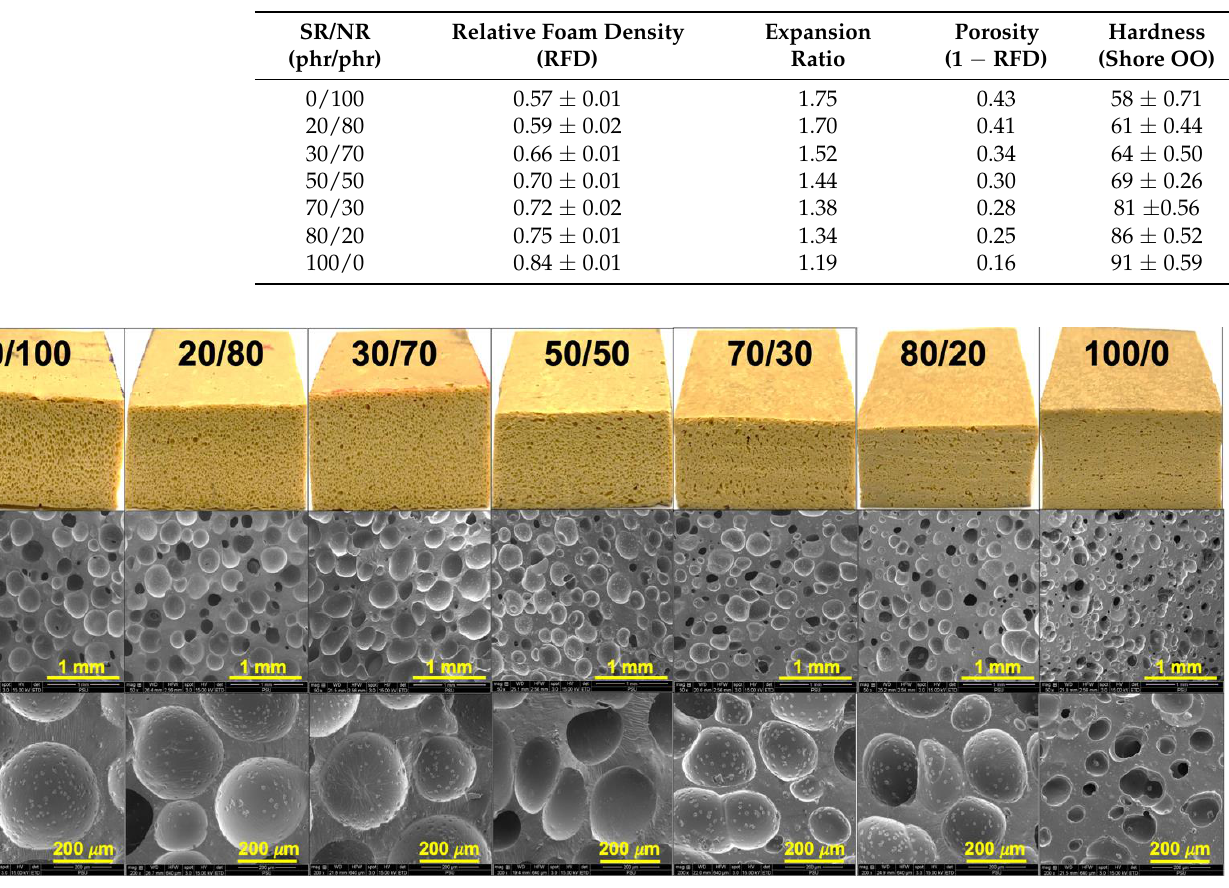
Table 3. Physical properties of SR/NR blends.